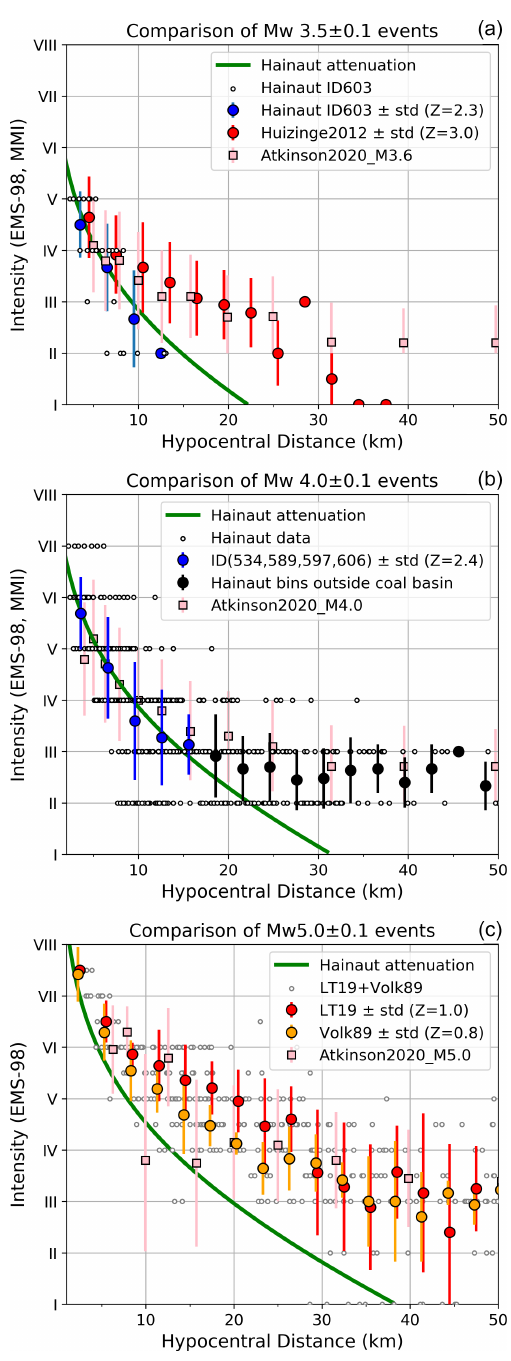
Figure 9. Comparison of binned (3km) intensity–distance obser- vations for (a) M w = 3 . 5 earthquakes in Hainaut, in Huizinge (Groningen gasfield, NL; Dost and Kraaijpoel, 2013), and in Okla- homa (USA; Atkinson, 2020), (b) M w = 4 . 0 earthquakes in Hainaut and in Oklahoma (US), and (c) M w = 5 . 0 earthquakes in Le Teil (FR; Schlupp et al., 2021), Völkershausen (DE; Leydecker et al., 1998) and Oklahoma (USA). IDPs (small grey dots), mean inten- sity (coloured dots or squares) and standard deviation (bars) of the different intensity datasets are shown in comparison with the fast decay of the Hainaut intensity attenuation relationship (green line). Z = depth in